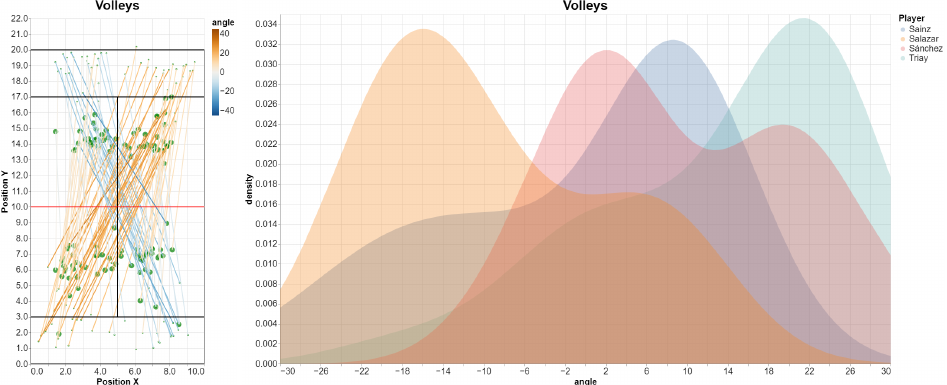
Figure 11. Direction of the volleys for the women’s final, with shots colored by angle ( left ). We show as well the estimated density distribution of the volley angle variable, for the four players ( right